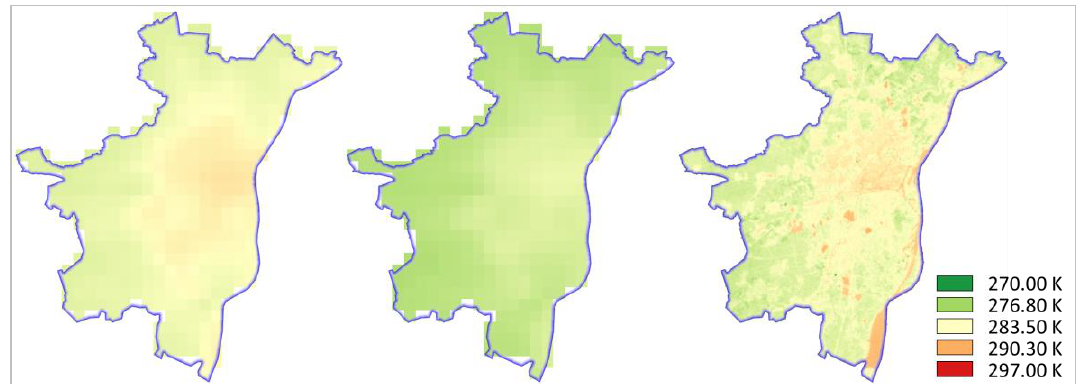
Figure 11 . Spring UHI map of Strasbourg at night when analysing all data from MODIS (left), typical days from MODIS (center), and the available data from ASTER (right)